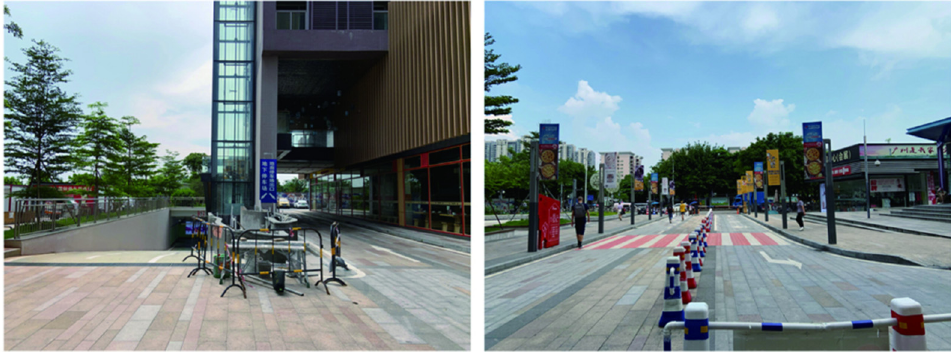
Figure 13. Current situation of parking lot entrances and exits of Nanpu Times.